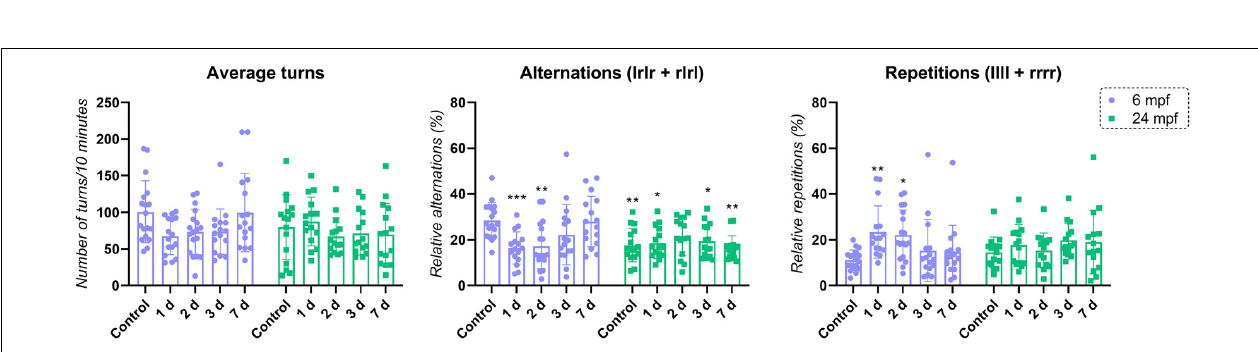
FIGURE 2 | FMP Y -maze response of 24 mpf animals 1, 2, 3, or 7 days after exposure to MS222. (A) Overall behavioral patterns/10 min. (B) Alternations and repetitions across time for 24 mpf controls vs. 1 day vs. 2 days vs. 3 days vs. 7 days after MS222 exposure. Data were represented as mean ± S.E.M and analyzed by one-way ANOVA or two-way repeated measures ANOVA, followed by Tukey’s test multiple comparison test ( n = 15–16 per group).